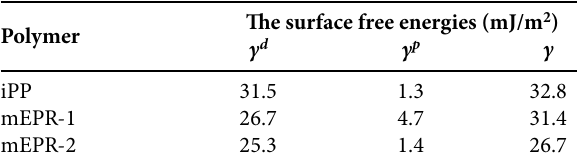
Table 4. The surface free energy ( γ ) of the iPP and elastomers and their dispersive ( γ d ) and polar component values ( γ p ) evaluated